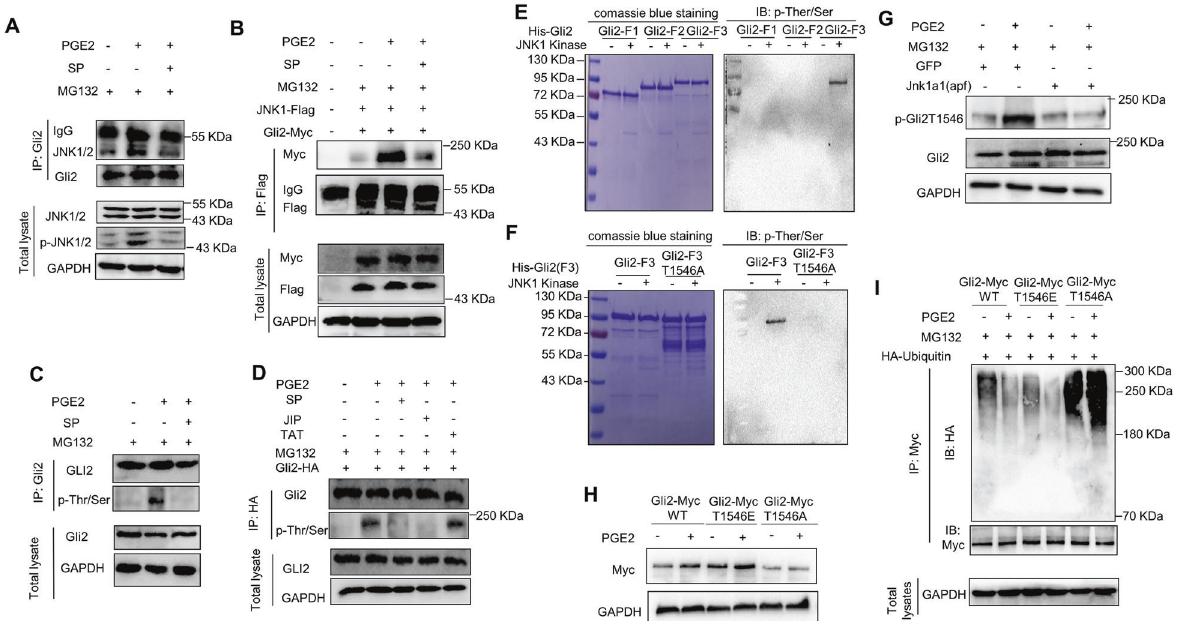
Fig. 3 JNK activation by PGE2 protects Gli2 from ubiquitin-proteasomal degradation by phosphorylating Gli2 at Thr1546. A Immunoprecipitation-western blot analysis of the interaction between endogenous Gli2 with JNK in 293T cells treated with PGE2, SP, and MG132 as indicated for 1 h. B Immunoprecipitation-western blot analysis of the interaction between exogenous Gli2 with JNK in 293T cells expressing Flag-tagged JNK1, andMyc-tagged Gli2 after exposure to PGE2, SP, and MG132 as indicated for 1 h. C Immunoprecipitation-western blot analysis of Thr/Ser phosphorylation of endogenous Gli2 in LS174T cells after exposure to PGE2, SP, and MG132 as indicated for 1 h. D Immunoprecipitation-western blot analysis of Thr/Ser phosphorylation of exogenous Gli2 in LS174T cells expressing HA-tagged Gli2 after exposure to PGE2, SP, and MG132 as indicated for 1 h. E The in vitro kinase assay was performed with recombinant JNK1 and indicated His- tagged Gli2 fragments, followed by immunoblotting with anti-phosphorylation-Thr/Ser antibody. F The in vitro kinase assay was performed with recombinant JNK1 and His-tagged Gli2-F3 fragments and His-tagged Gli2-F3 harboring the alanine substitution of theronine 1546 (Gli2- F3 T1546A), followed by immunoblotting with anti-phosphorylation-Thr/Ser antibody. G Immunoblot analysis of Thr1546 phosphorylation of Gli2 in LS174T cells expressing GFP, and Jnk1a1(apf) after exposure to PGE2, MG132 as indicated for 1 h using speci fi c phosphor-Gli2Thr1546 antibody. H Immunoblot analysis of Myc-tagged Gli2 (Gli2-Myc WT), Myc-tagged Gli2 with the glutamine substitution of threonine 1546